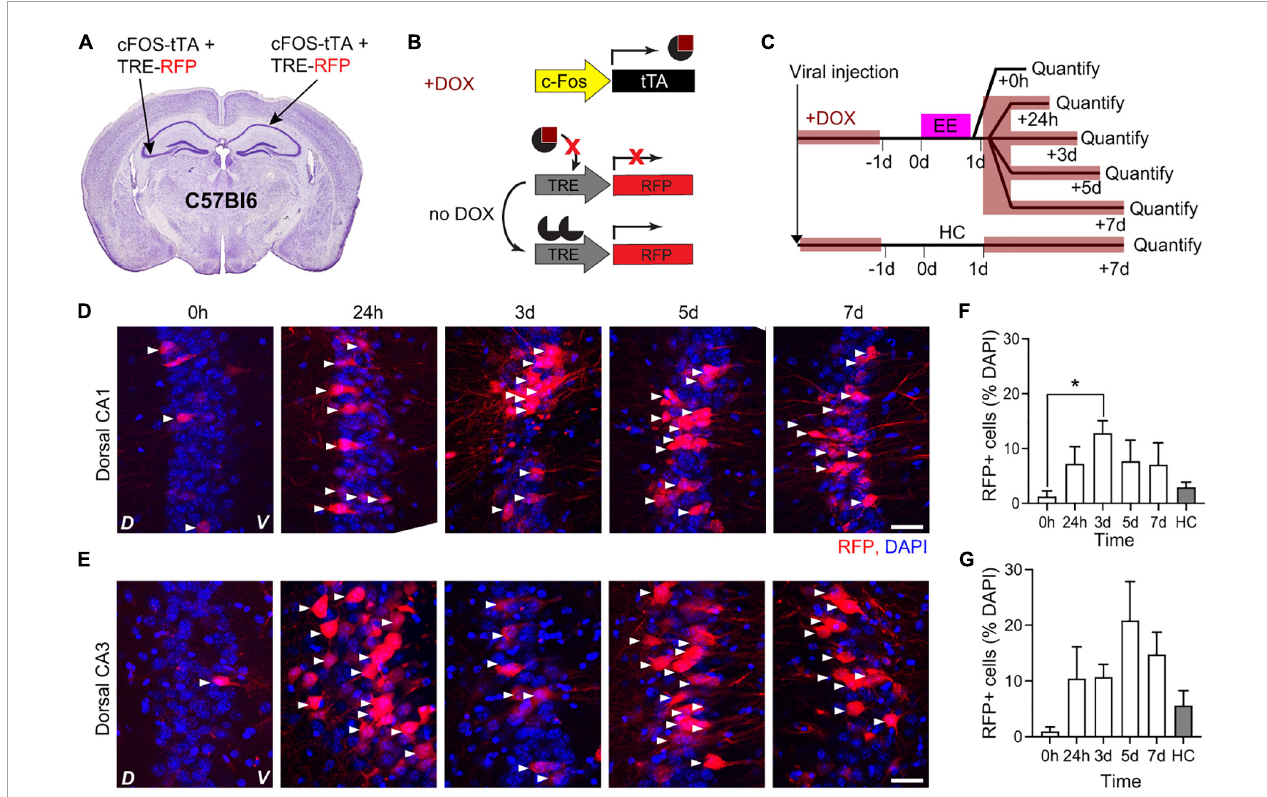
FIGURE1 Kinetics of cFostTA-dependent expression of RFP in dorsal hippocampus. Schematic description of the viral injection sites in WT animals (A) , the viral constructs injected (B) , and the experimental design (C) . Confocal pictures, single Z-planes, of dCA1 (D) and dCA3 (E) at different time points after induction of c-FOS-dependent expression of RFP upon exposure to EE. Red, RFP; blue, DAPI. White triangles indicate RFP-positive cells. D, Dorsal, V, Ventral. Scale bar = 20 µ m. (F) The percentage of RFP-expressing over DAPI-positive cells in dCA1 at 3 days was significantly higher than 0 h and HC ( p 0h - 24h > 0.999, * p 0h - 3d = 0.02, p 0h - 5d > 0.999, p 0h - 7d > 0.89, p 0h − HC > 0.99; n 0h = 5, n 24h = 5, n 3d = 7, n 5d = 3, n 7d = 5, n HC = 5; Kruskal–Wallis test after Dunn’s correction for multiple comparisons). (G) The percentages of RFP-expressing over DAPI-positive cells in dCA3 at 3 and 5 days were significantly higher than 0 h when compared directly ( p 3d - 0h = 0.019 and p 5d - 0h = 0.035; n 3d = 7, n 0h = 5, n HC = 5; Mann–Whitney U-test) but showed only a trend after correction for multiple comparisons ( p = 0.076; Kruskal–Wallis test after Dunn’s correction for multiple